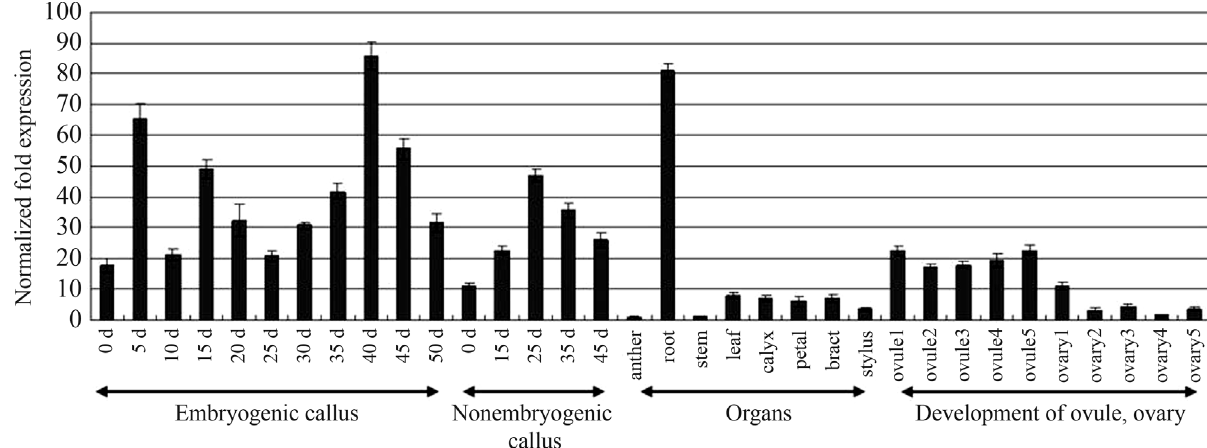
Figure 2 - AcSERK3 expression assessed by qRT-PCR. The results are shown as the fold-change compared to the expression levels in anther and were normalized relative to the housekeeping gene AcACTIN in callus. Embryogenic callus - callus cultured in medium containing 2,4-D. Non-embryogenic callus - callus cultured in 2,4-D-free medium. For callus tissue, the time intervals are in days (d). The columns represent the mean (cid:5) SD of X determina- tions.